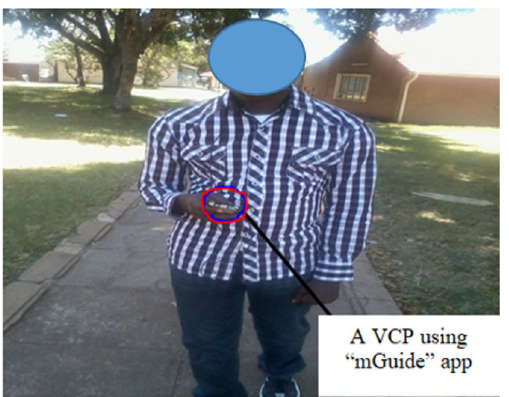
Fig. 9 A photograph of visually challenged student walking along a path in Kenyatta University (courtesy of directorate of disability)